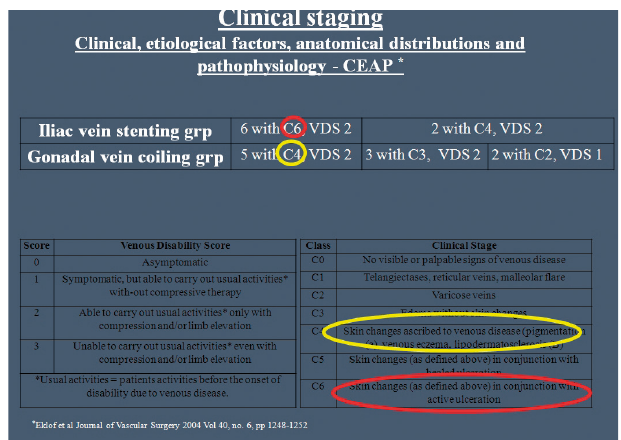
Fig. 4. Clinical disease severity